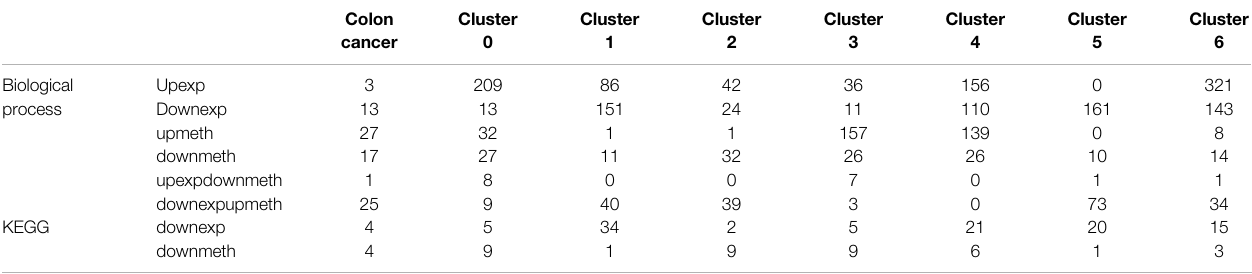
TABLE 2 | The enriched term number of function analysis for dysregulated